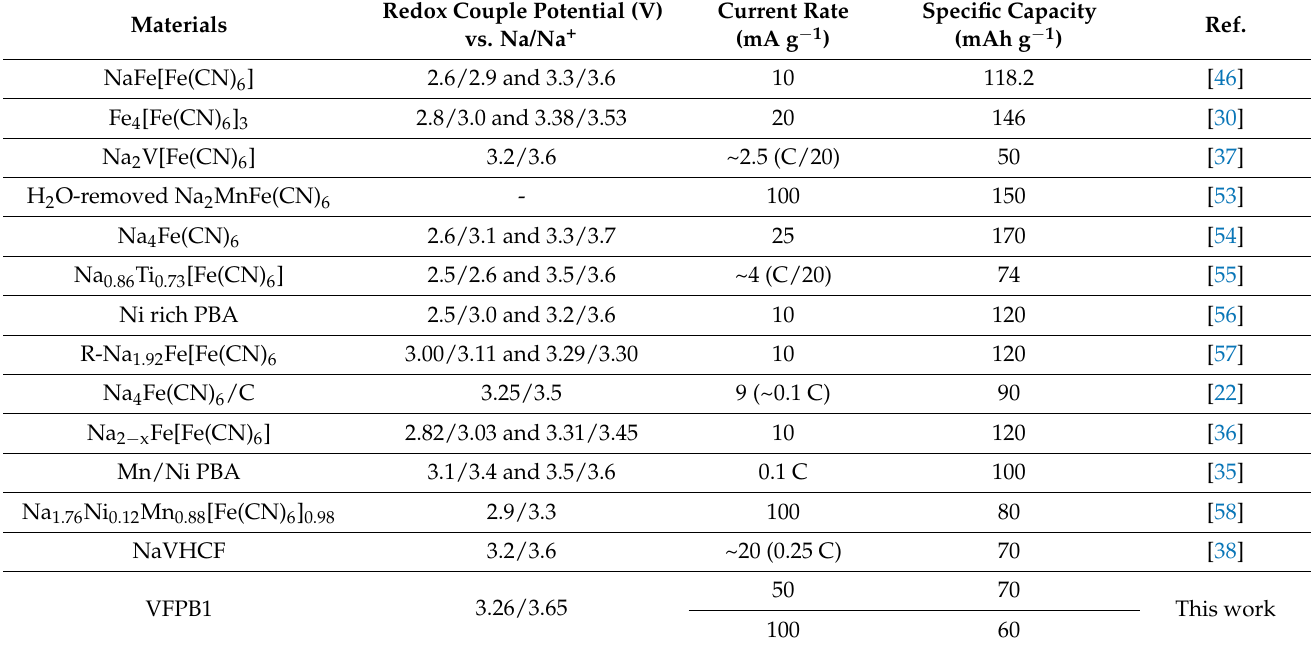
Table 1. Comparison of the performances of Prussian blue analog-based cathode materials for sodium-ion batteries.